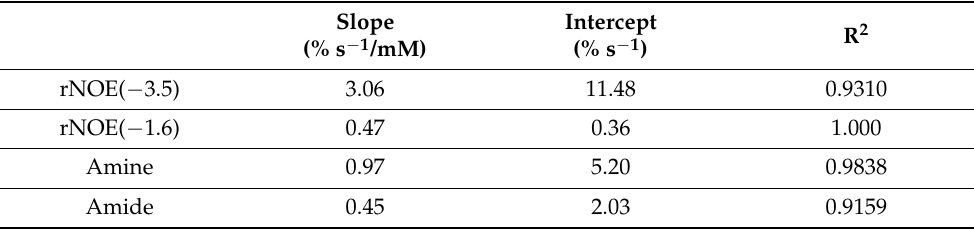
Table 1. Regression results for associations between cholesterol concentration and area under the curve (AUC) of the residuals of apparent exchange-dependent relaxation rate ( AREX resid ) in lipid extracts from cell